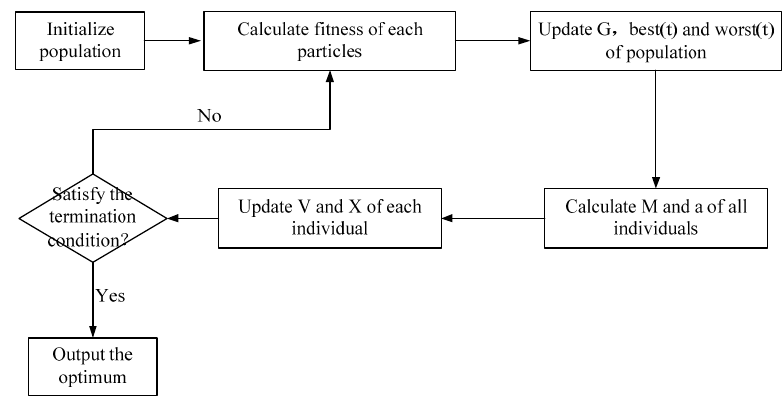
Figure 2. Flowchart of gravitational search algorithm (GSA).